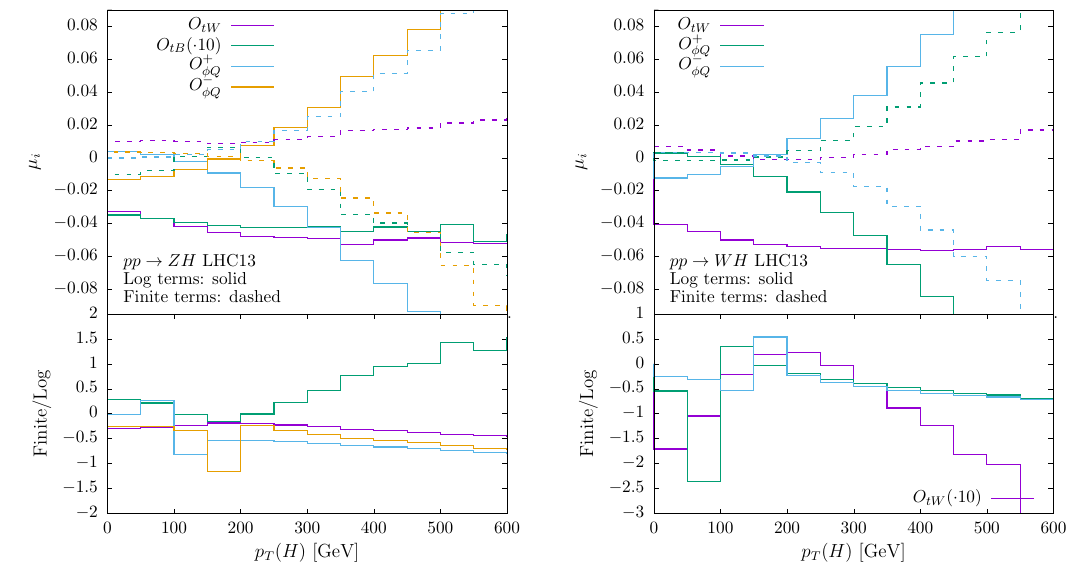
Figure 9 . Comparison of logarithmic and (cid:12)nite terms in the Higgs transverse momentum distri- bution in ZH and WH production for the di(cid:11)erent operators. The lower panels show the ratio of the (cid:12)nite over the logarithmic